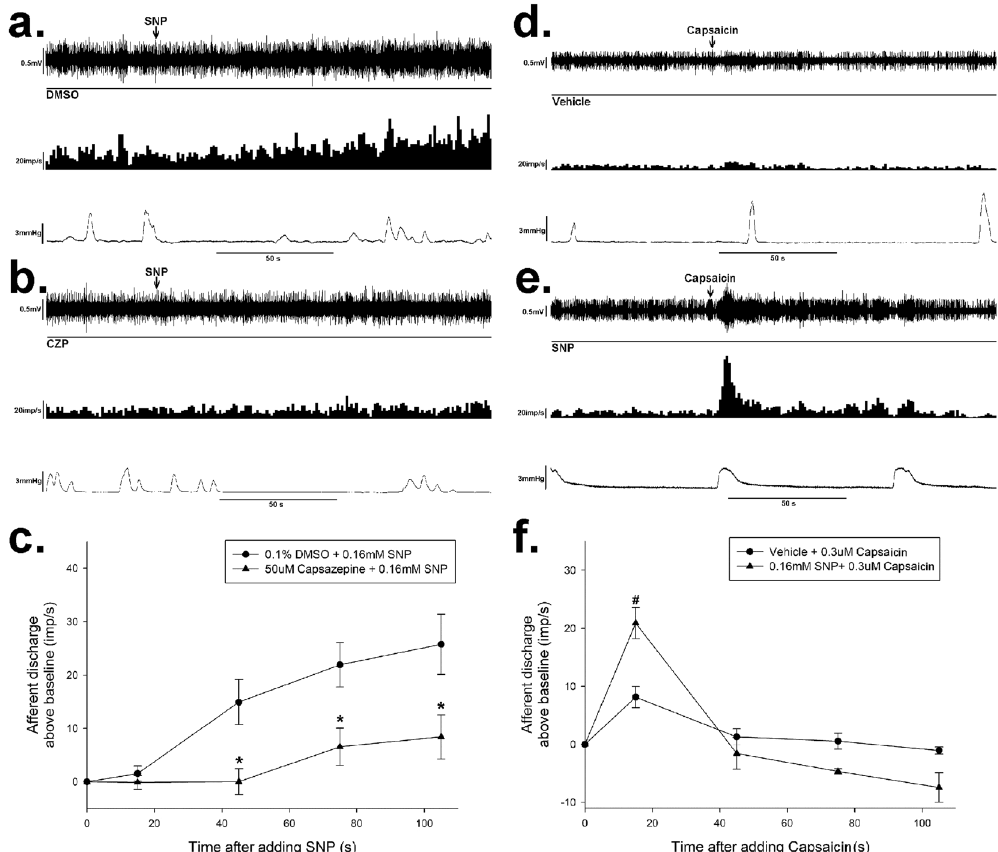
Figure 5. The excitatory effect of SNP was mediated by TRPV1. ( a ) Response of whole nerve activity before and after SNP administration in the presence DMSO (0.1%). The upper trace shows the raw recording of whole nerve discharge, the middle trace is the number of nerve discharge in 3 s, and the lower trace shows corresponding intraluminal pressure. The arrows indicate the administration of SNP (0.16 mM). DMSO didn’t change the excitatory effect of SNP on the spontaneous afferent discharge. ( b ) Response of whole nerve activity to SNP in the existence of CZP (50 µ M). SNP (0.16 mM) failed to increase the spontaneous afferent discharge. ( c ) Summary values showing that the excitatory effect of SNP (0.16 mM) was inhibited by CZP (50 µ M). n = 6 in each group, * P < 0.05 vs DMSO group, Students’ t -test. ( d ) Response of whole nerve activity to capsaicin (0.3 µ M). The application of capsaicin increased the spontaneous afferent discharge. ( e ) Response of whole nerve activity to capsaicin (0.3 µ M) in the presence of SNP (0.16 mM). SNP markedly increased the capsaicin- evoked mesenteric afferent firing. ( f ) Summary values showing that the excitatory effect of capsaicin (0.3 µ M) was enhanced by SNP (0.16 mM). n = 6 in each group, # P < 0.01 vs vehicle, Students’ t